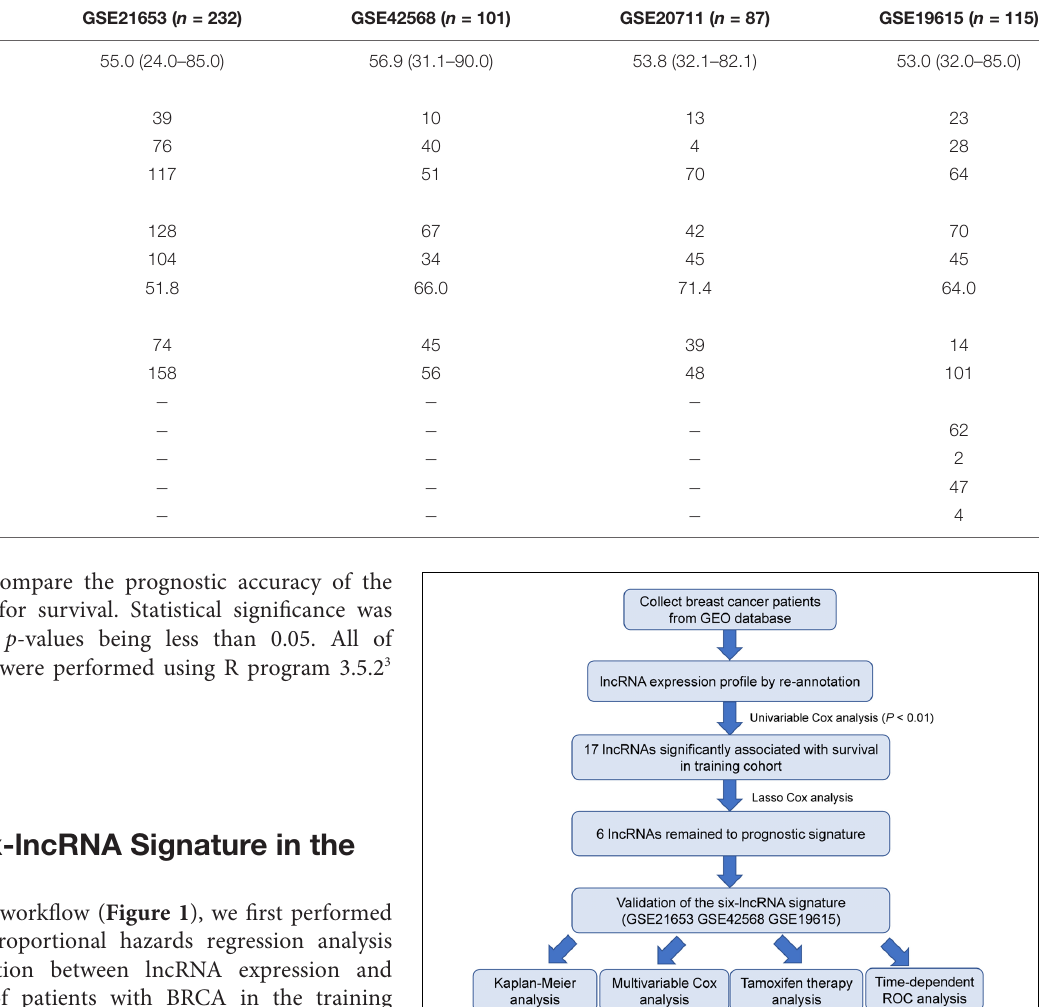
TABLE 1 | The Clinical and pathological characteristics of patients in four GEO cohorts.